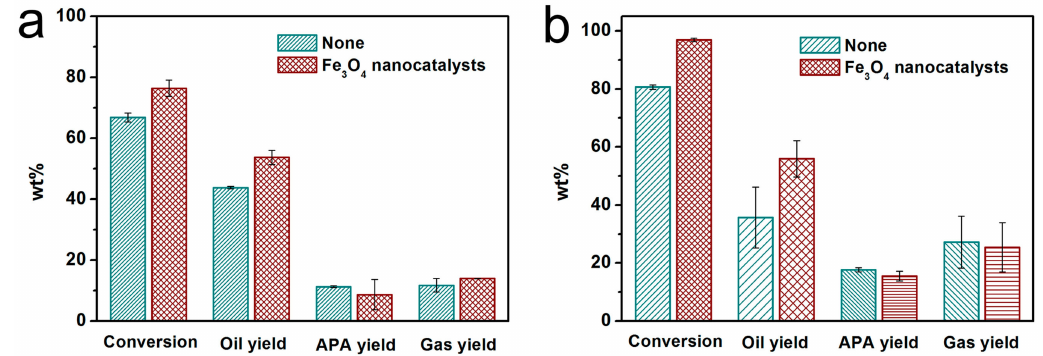
Figure 2. Results of the direct liquefaction of ( a ) Heishan coal and ( b ) Dahuangshan coal with Fe 3 O 4